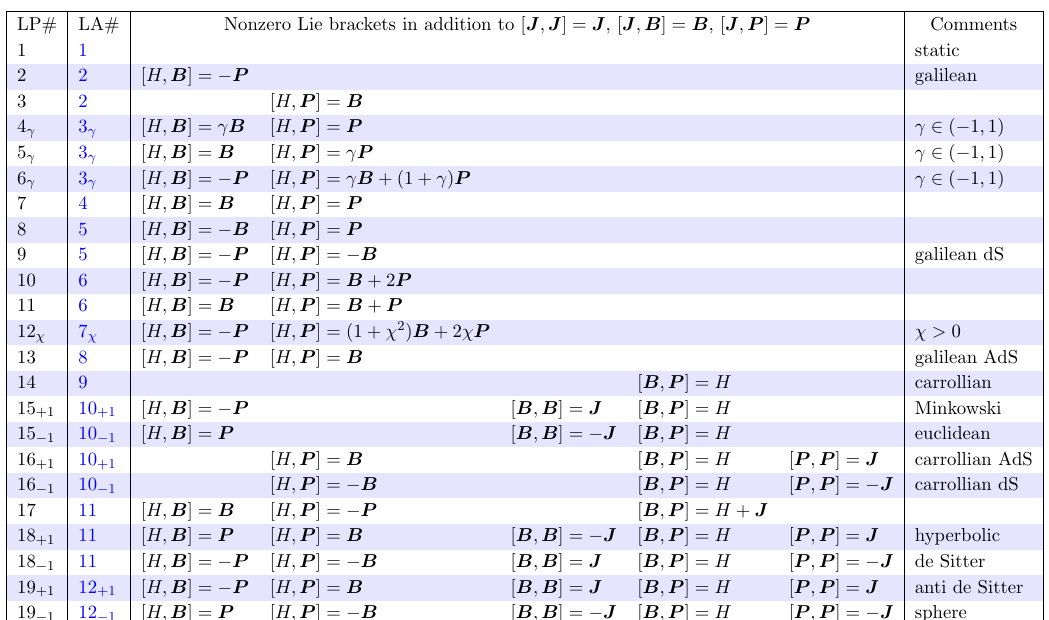
Table 5 . Lie pairs for kinematical Lie algebras ( D (cid:21) 3).